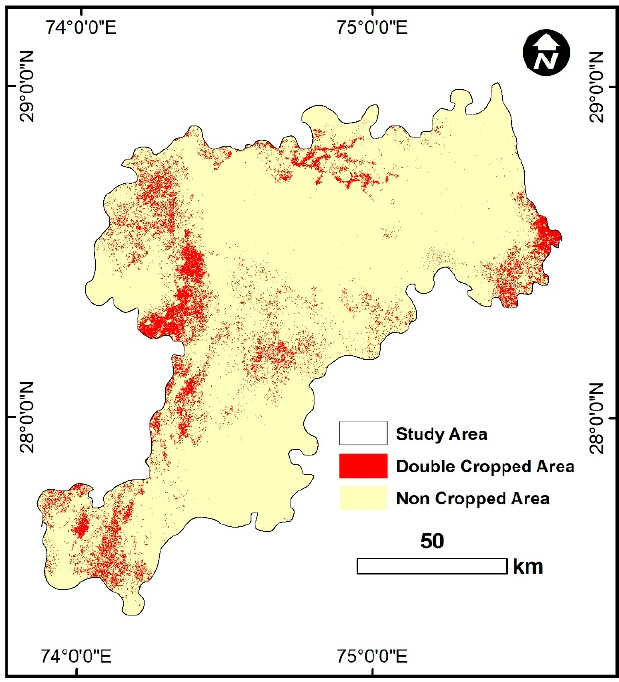
Figure 9. Double crop distribution (Datum: WGS84).